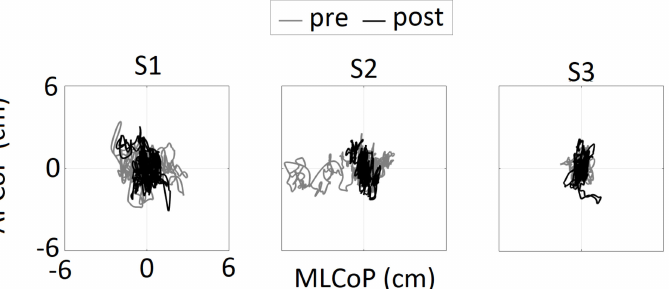
Figure 2. Statokinesiogram representations of all three participants showing the center of pressure (CoP) excursions in anterior-posterior (AP) and medial-lateral (ML) directions. APCoP—anterior- posterior center of pressure; MLCoP—medial-lateral center of